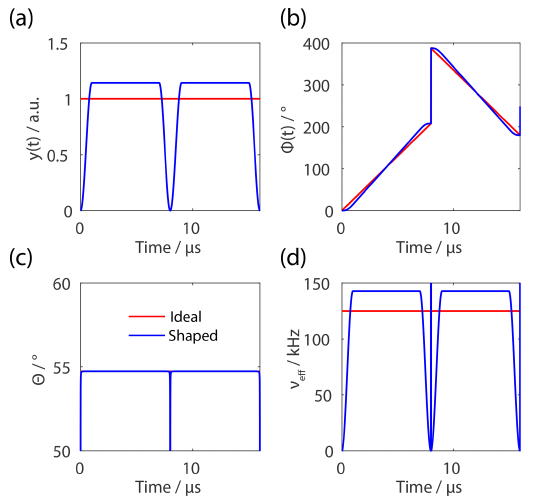
Figure 3. Representation of possible implementation for FSLG de- coupling with shaped pulses guaranteeing a constant effective-field angle. In red, the ideal FSLG pulse sequence is shown assuming rectangular pulses and blue the implementation of shaped pulses. (a) Flip-angle-corrected amplitude with finite pulse edges of 0.4µs. (b) Time-dependent phase ramp with a 180 ◦ phase jump for the sec- ond pulse. (c) Resulting effective-field angle which is kept constant at the magic angle for both implementations. (d) Resulting effective field which corresponds to a net rotation of 2 π at 125kHz.